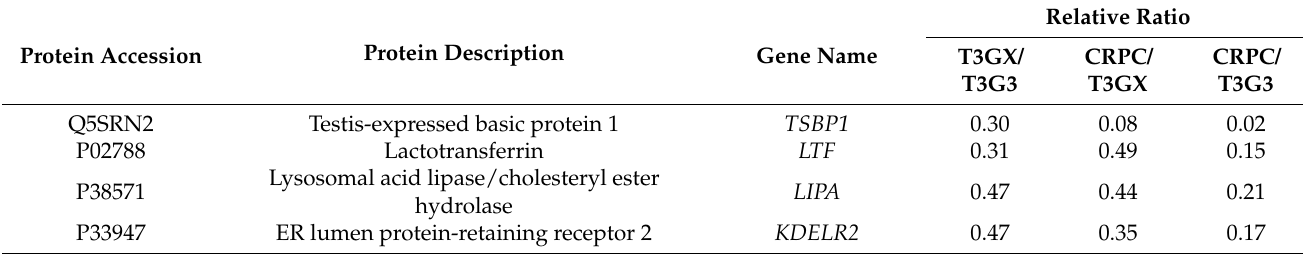
Table 2. Protein list of group 4, indicating a continuous decrease from T3G3 to CRPC